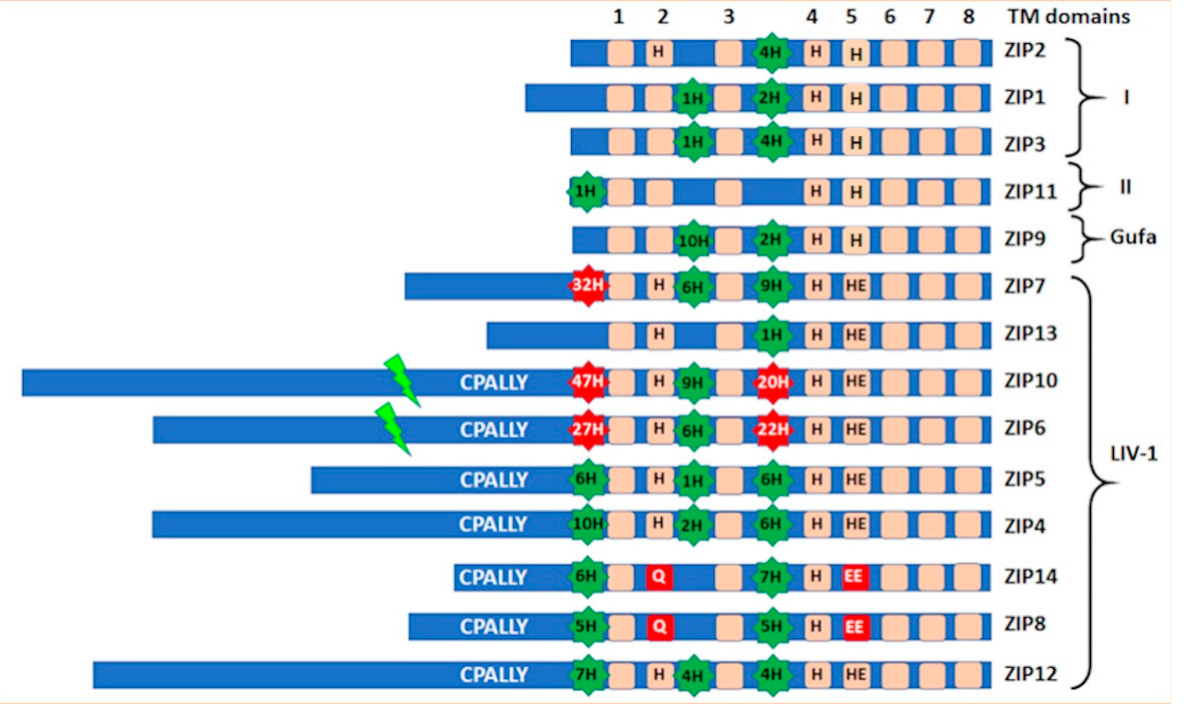
Figure 1. Comparison of features of the 14 human ZIP family members. The 14 human ZIP family members can be divided into four sub-groups with the LIV-1 family containing nine members. The highly conserved HEXPHEGD motif in TM5 of the LIV-1 subfamily is shown by HE. Conserved histidine residues in TM domains are shown by H. The different residues for ZIP8 and ZIP14 in TM2 and TM5 are shown in red boxes. Regions of histidine residues in the N-terminus, extracellular loop TM2–3 and intracellular loop TM3–4 are shown with green backgrounds with 10 residues or less and with red backgrounds when in excess of 10 residues. The predicted PEST site for N-terminal cleavage of ZIP6 and ZIP10 is indicated by a green shard. The CPALLY motif is present in the N-terminus of all LIV-1 family members that can reside on the plasma membrane.